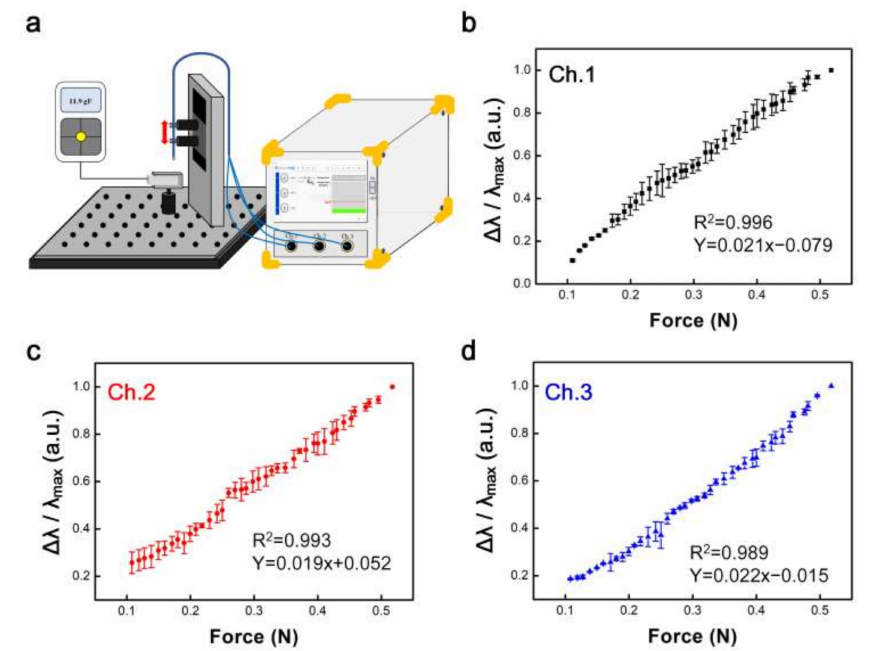
Figure 3. ( a ) Schematic integration of the force sensor system. ( b – d ) Calibration curve between normalized wavelength and force at intervals of 0.01 N ( n = 3). Table 1. R square, linearity, standard error, and hysteresis of three FBGs. R